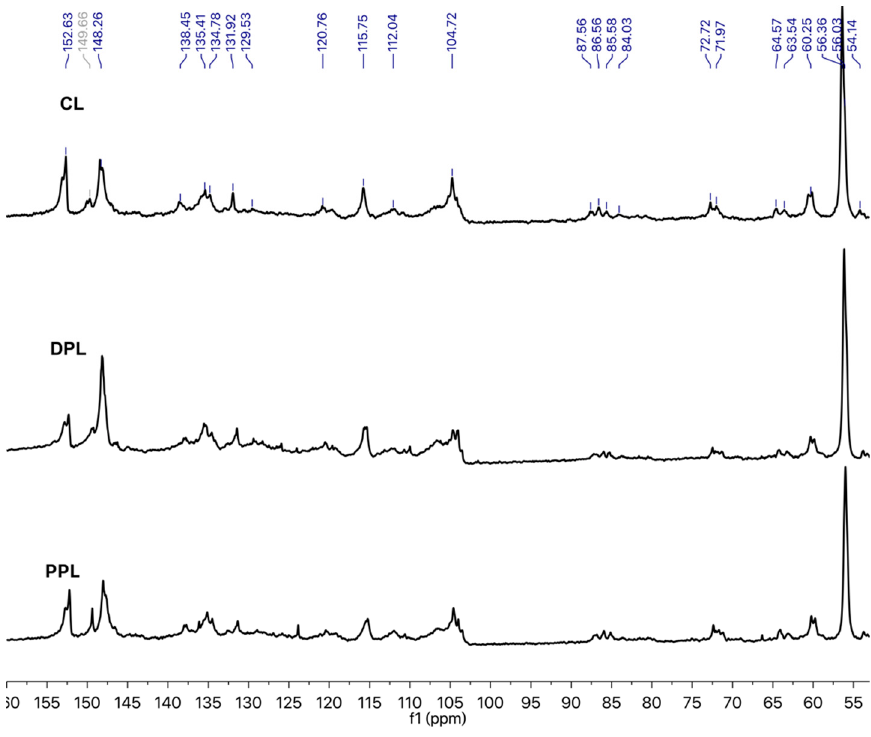
Figure 4. Quantitative 13 C NMR spectra of CL, DPL and PPL.